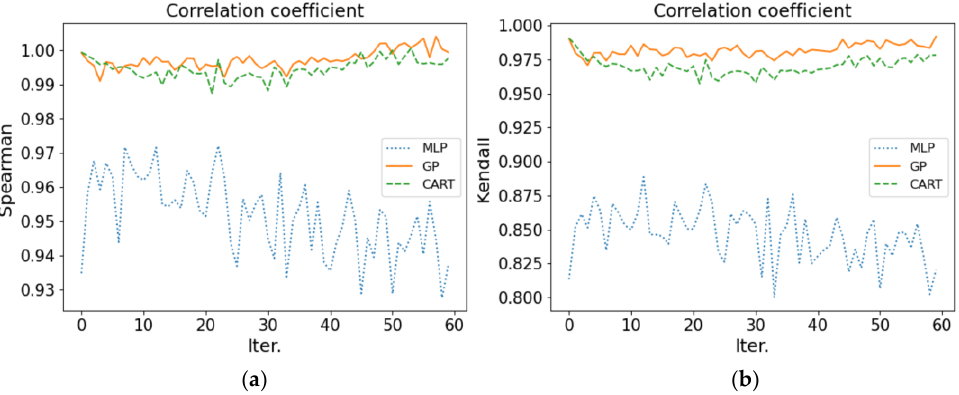
Figure 5. Correlation coefficient comparison of surrogate models: ( a ) Spearman’s rank correlation coefficient; ( b ) Kendall’s rank correlation coefficient. coefficient; ( b ) Kendall’s rank correlation